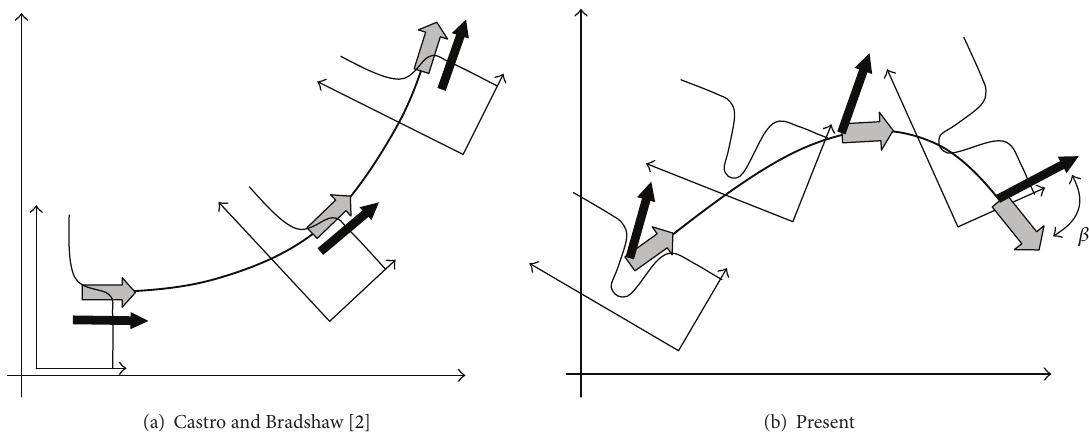
Figure 9: Sketch of the convection and shear layer directions. Grey arrows indicate direction of convection; thick black arrows indicate orientation of shear layer in proximity to the bow apex of the incoming